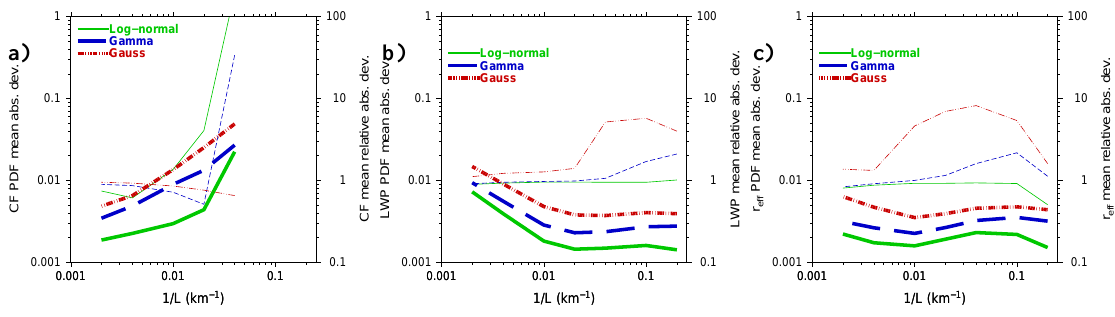
Fig. 5. Mean absolute deviations between the observed and the analytical PDFs in thick lines; thin lines show the mean absolute deviation between fit and observations when weighted by the inverse of the observed PDF at each point.